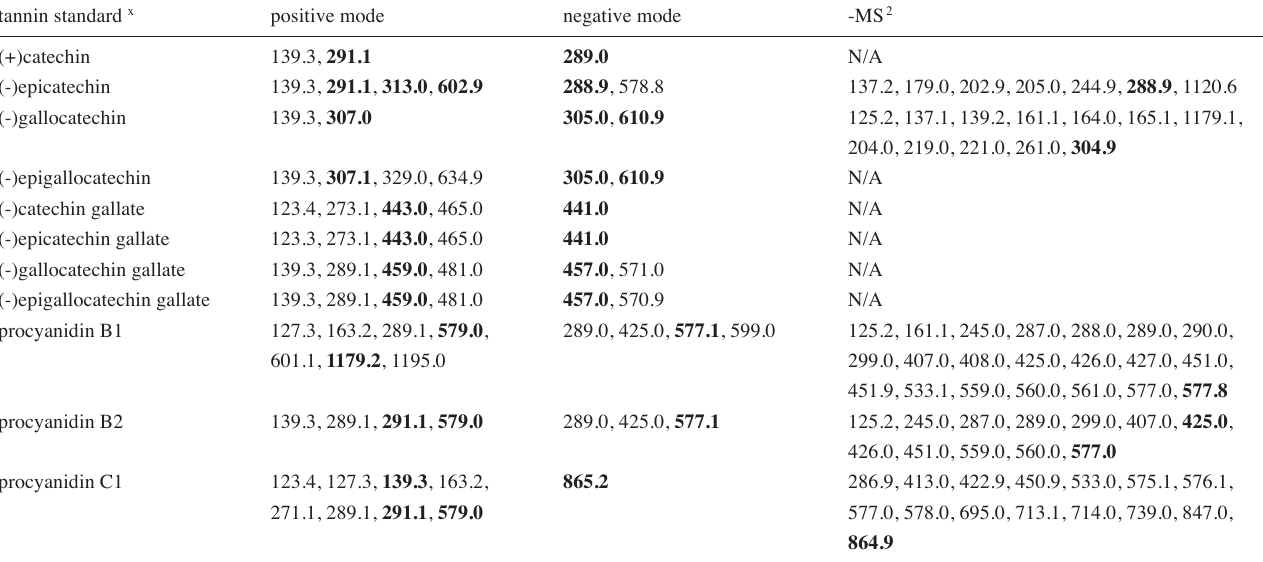
tannin standard